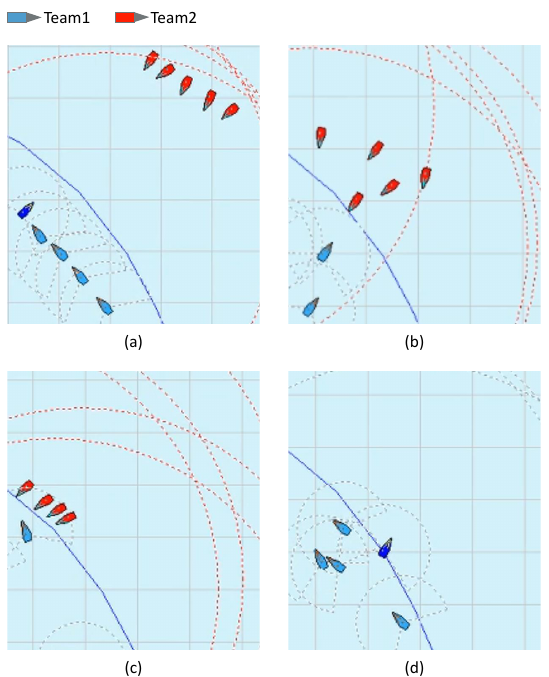
Figure 10. Experimental results of cooperative–competitive reinforcement learning: ( a ) starting positions of the red team and blue team, ( b ) task planning of two teams with different goals, ( c ) red team has reached the blue team’s area, ( d ) blue team has completely defeated red